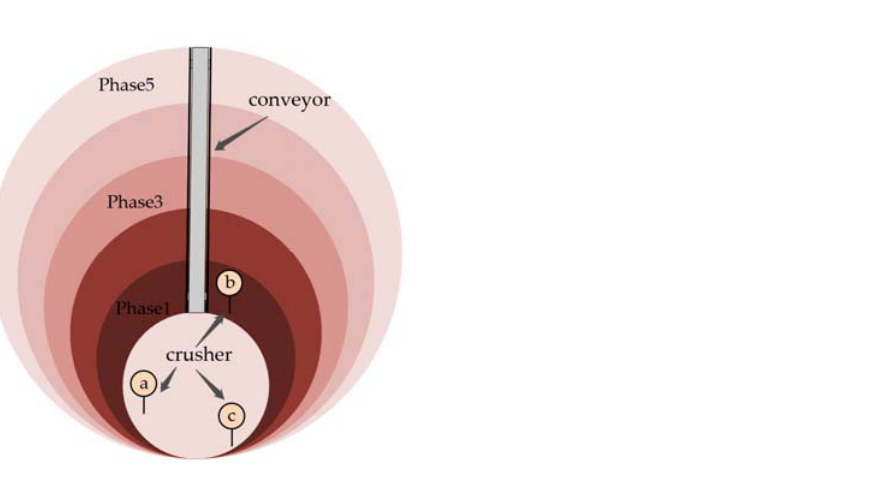
Figure 2. An overhead view of a sample IPCC system in an open pit in which there are one conveyor and three crushers (a–c)